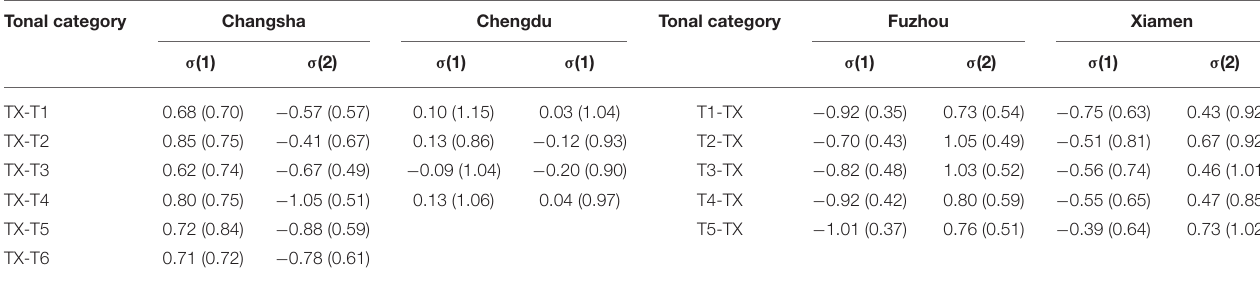
TABLE 2 | The mean normalized duration (in z-score) and standard deviation (in bracket) with different tonal categories in σ (2) in Changsha and Chengdu dialects, whereas tonal categories in σ (1) in Fuzhou and Xiamen dialects. Tonal category Changsha Chengdu Tonal category Fuzhou